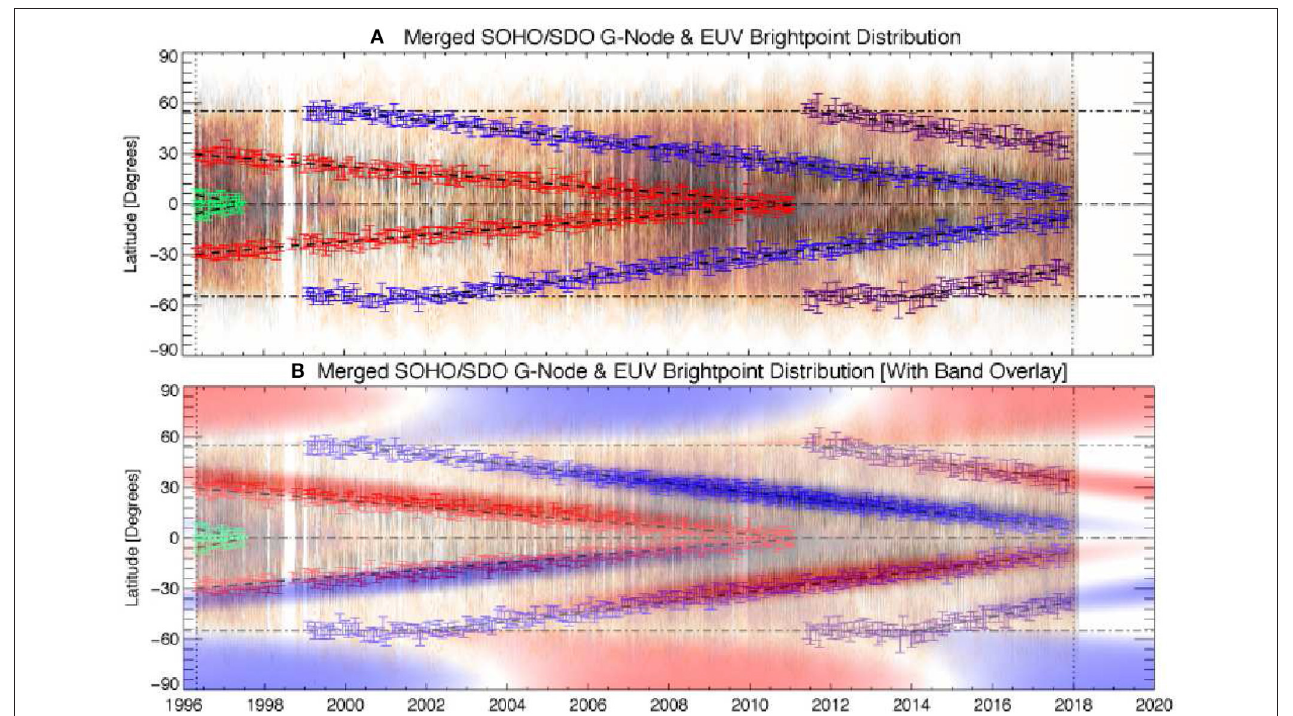
FIGURE 3 | Illustrating the appearance of the ESC in the contemporary era, extending the analysis of McIntosh et al. (2014a) to the present. Panel (A) shows the latitudinal variation of EUV bright points and their associated magnetic scale marker “g-nodes” ( McIntosh et al., 2014b) as observed respectively by SoHO and SDO. Fitting the bright point and g-node bands in latitude-time distribution allows us to track the activity bands of solar cycle 22 (green), 23 (red), 24 (blue), and 25 (purple). Note that cycle 22 terminates in 1997, cycle 23 terminates in 2011, and that we anticipate cycle 24 to end in late 2019 or early 2020. Panel (B) shows something called a “band-o-gram,” a schematic motivated by the data, to illustrate the magnetic polarities and potential interaction of the magnetic systems present. [Credit: McIntosh et al., 2014b, reproduced with permission (c)